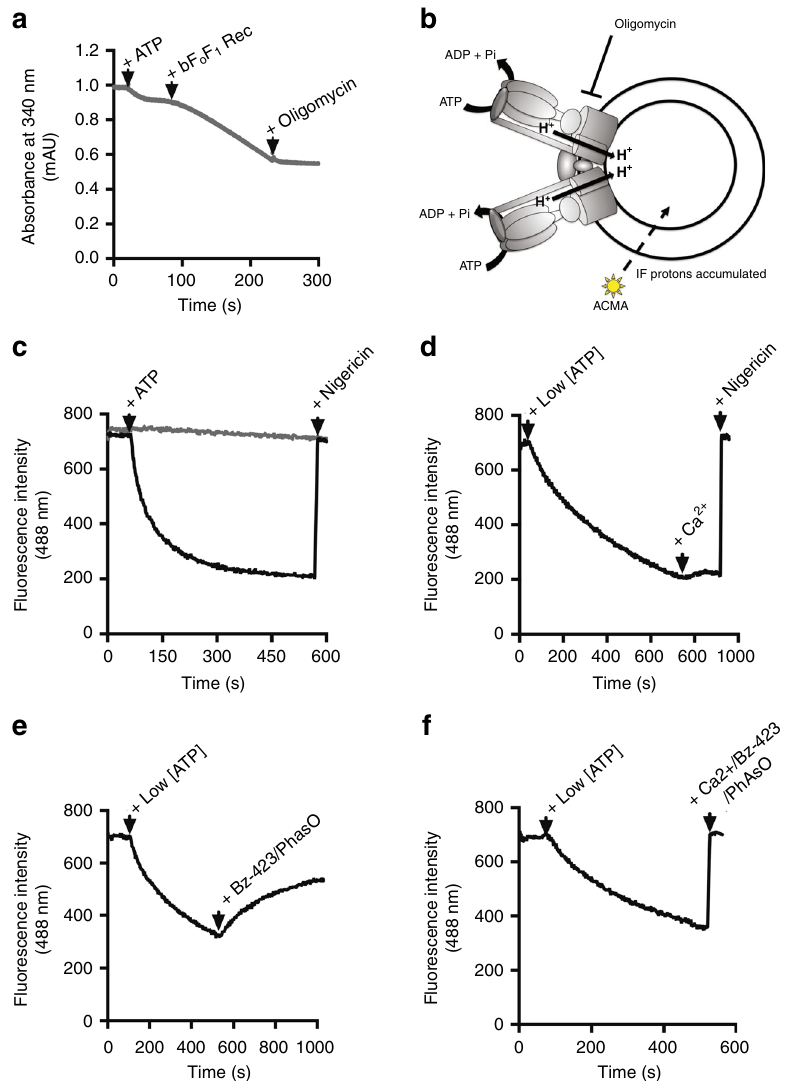
Fig. 2 Release of the H + gradient of F-ATP synthase proteoliposomes by Ca 2 + and PTP activators. a ATP hydrolysis by liposome-reconstituted F-ATP synthase was measured with an ATP-regenerating assay, as described in Methods by monitoring absorbance at 340 nm. ATP (2.5 mM), 10 μ g proteoliposomes (bF O F 1 Rec), and 2 μ M oligomycin were added where indicated. b Scheme of the ACMA-quenching assay involving F O F 1 complexes within the proteoliposome membrane. Protons pumped into the vesicle lumen by ATP hydrolysis cause the accumulation (and quenching) of ACMA fl uorescence. Oligomycin prevents ATP hydrolysis as shown in panel a . c Where indicated 2.5 mM ATP and 1 μ M Nigericin; gray trace, 2 μ M oligomycin was present. d Where indicated 0.125 mM Mg 2 + ATP, 2 mM Ca 2 + , and 1 μ M Nigericin. e Where indicated 0.125 mM Mg 2 + ATP, 150 μ M Bz-423, and 60 μ M PhAsO. f Where indicated 0.125 mM Mg 2 + ATP, 2 mM Ca 2 + , 150 μ M Bz-423, and 60 μ M PhAsO. Each trace is representative of three similar experimental replicates. Source data for panels a , c – f are provided as a Source Data fi